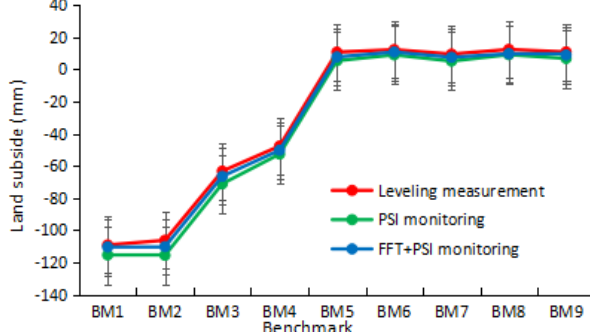
Figure 6. Comparison of Monitoring